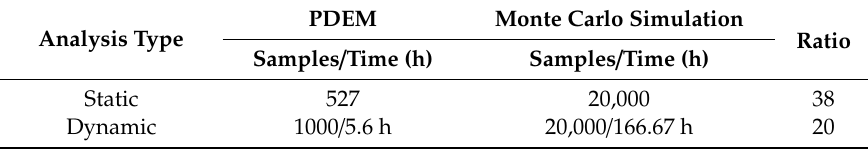
Figure 10. CDF of displacement of laterally loaded pile subjected to seismic excitation with random peak ground acceleration (PGA). Table 3. Comparison of computation amounts and times between PDEM and Monte Carlo